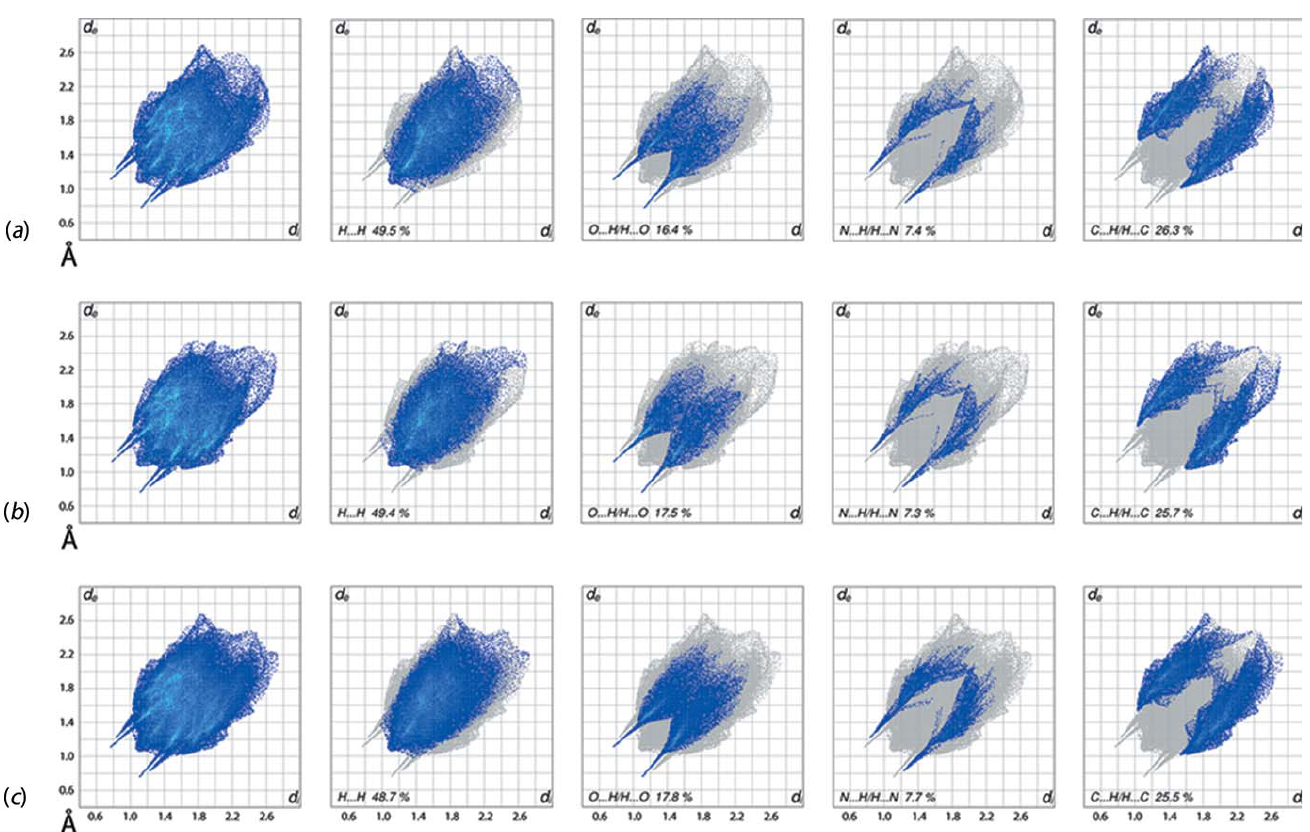
Figure 7 The full two-dimensional fingerprint plot and those delineated into H (cid:3)(cid:3)(cid:3) H, O (cid:3)(cid:3)(cid:3) H/H (cid:3)(cid:3)(cid:3) O, N (cid:3)(cid:3)(cid:3) H/H (cid:3)(cid:3)(cid:3) N and C (cid:3)(cid:3)(cid:3) H/H (cid:3)(cid:3)(cid:3) C contacts for the ( a ) O1- containing molecule, ( b ) the O4-molecule and ( c ) Fig. 4 a , and O5, C35, H22 and H36 C atoms, Fig. 4 b , indicate the contributions from the additional short interatomic C (cid:3) (cid:3) (cid:3) H/ H (cid:3) (cid:3) (cid:3) C and O (cid:3) (cid:3) (cid:3) H/H (cid:3) (cid:3) (cid:3) O contacts, Table 2, to the molecular